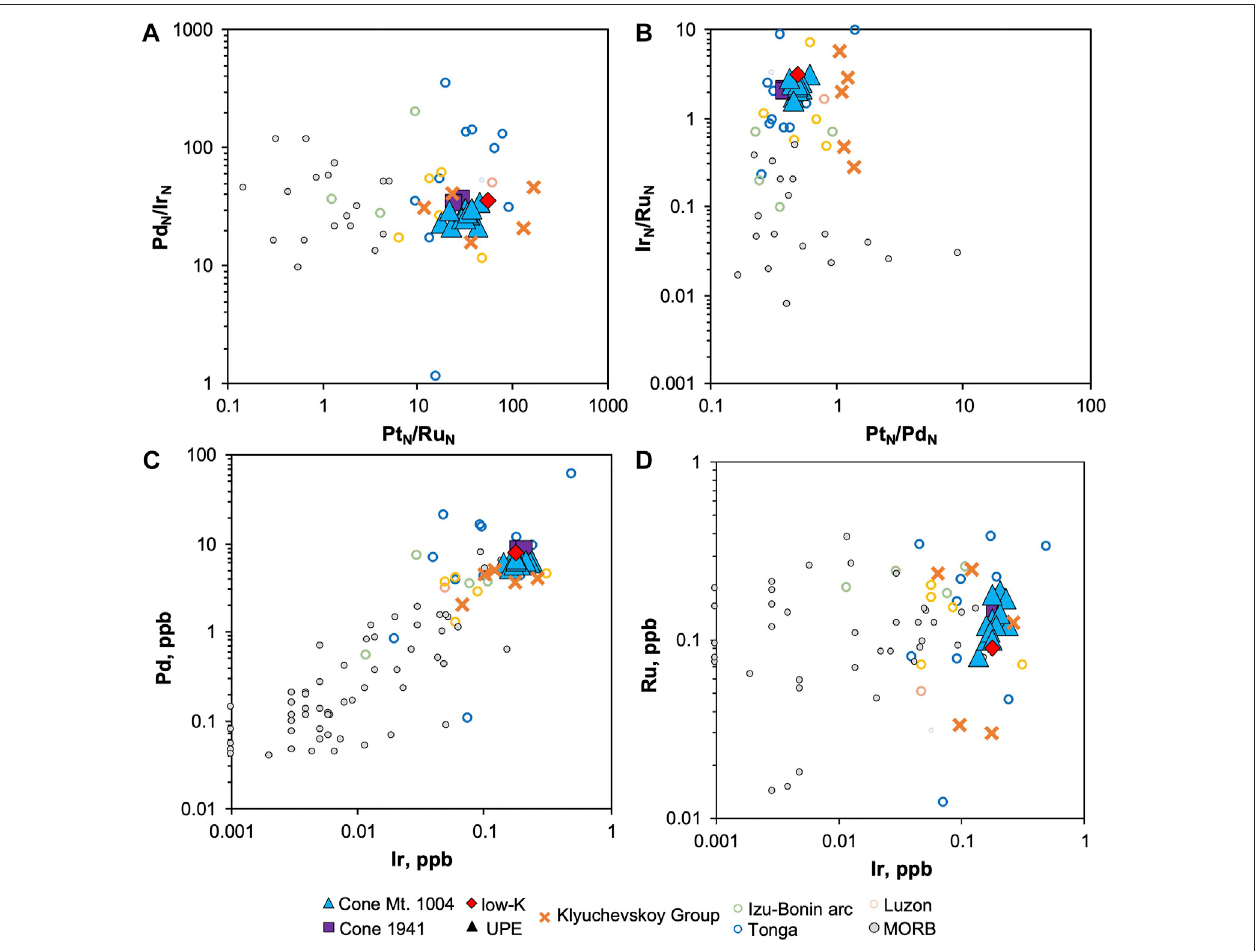
FIGURE8| Elementratios and contentsoftheTolbachiklavas compared toarcand MORB. Only sampleswithMgO contentof8 – 12 wt.%aredisplayed.Datafor the Klyuchevskoy Group — (Nekrylov et al., 2018, in press), Izu-Bonin arc — (Dale et al., 2008), Luzon arc — (Setiabudi et al., 2007), Tonga arc — (Dale et al., 2012), MORB — (Rehkämperetal.,1999;Peucker-Ehrenbrinketal.,2003;Jennerand O ’ Neill,2012;Kelleyetal.,2013;Yanget al.,2014;Reekie etal.,2019;Haoet al.,2021). Values normalized following Lyubetskaya and Korenaga (2007).